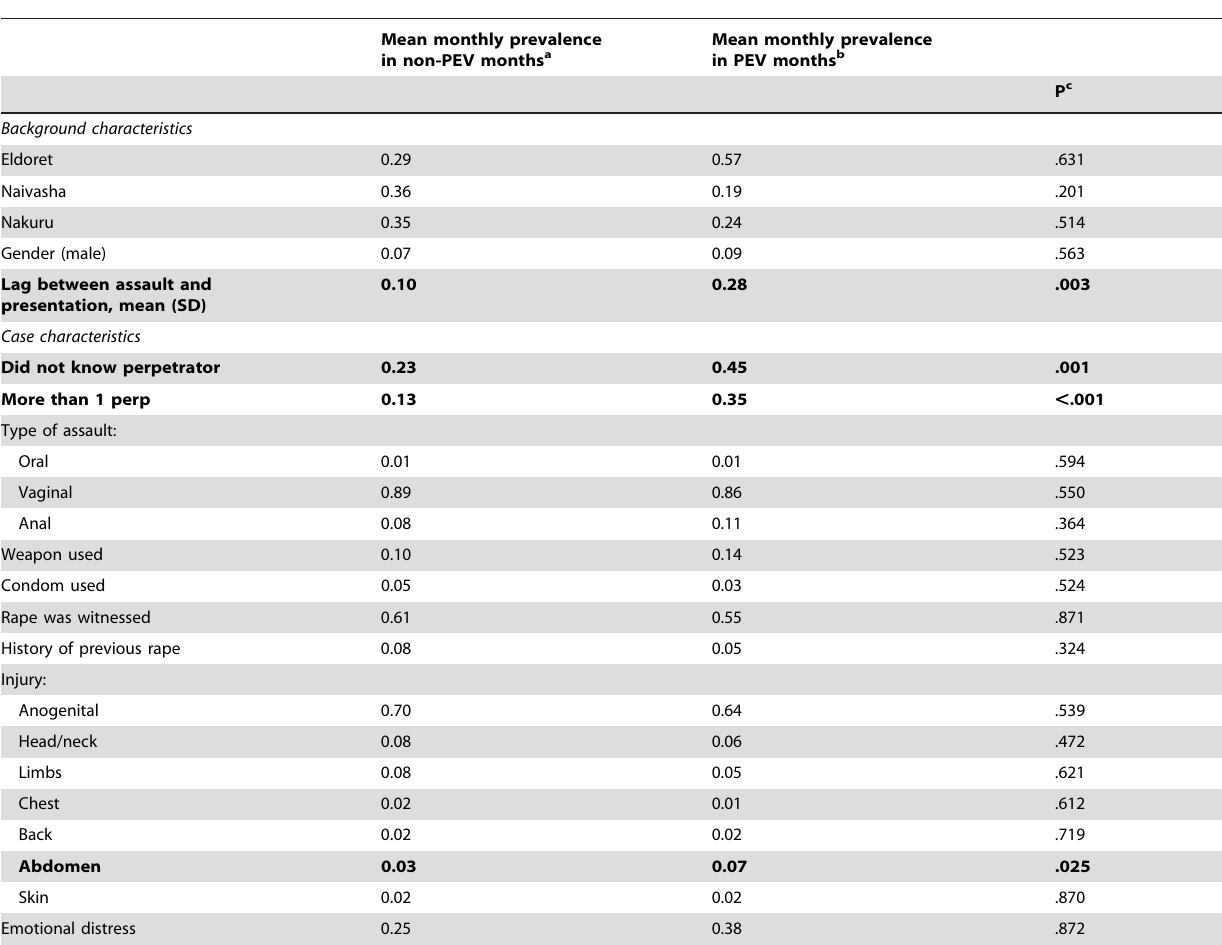
Table 1. Descriptive Characteristics of the sample, by PEV